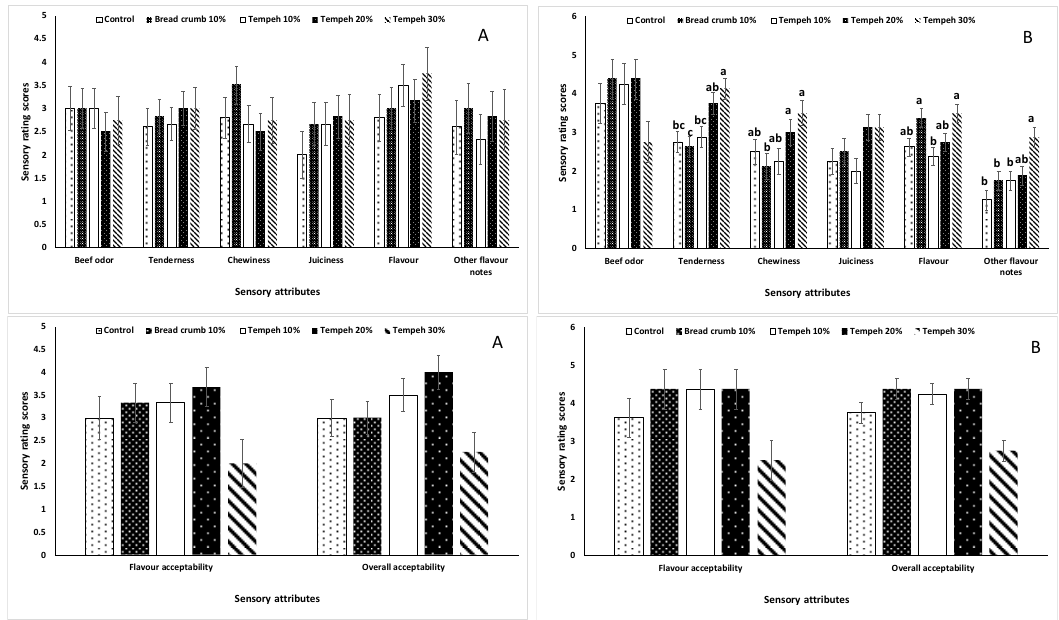
Figure 1. Sensory attribute scores of five beef patties substituted by tempeh at different levels. The patties were evaluated during focus groups (A = focus group 1 and B = focus group 2). a–c Within each sensory attribute, bars that do not share the same superscripts are significantly different ( p < 0.05).